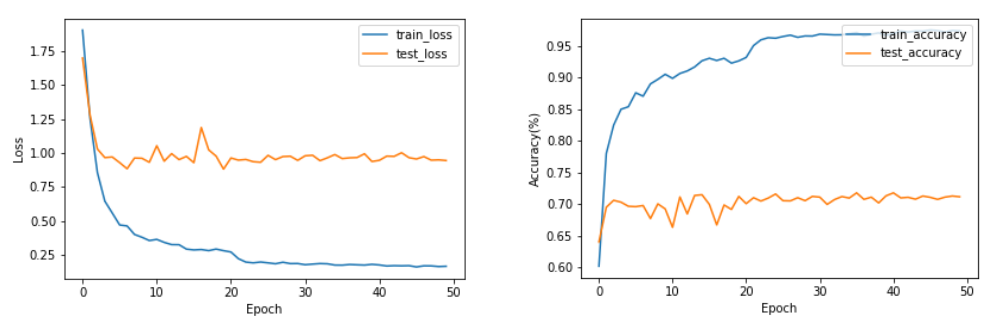
Table 4. Classification accuracy on the DB5 Dataset. (We use the same samples to test these methods). Figure 10. The loss and accuracy curves during training and testing on the exercise A of the NinaPro DB5 Dataset. During training and testing on the exercise A of the NinaPro DB5 Dataset, the phenomenon of overfitting appears.